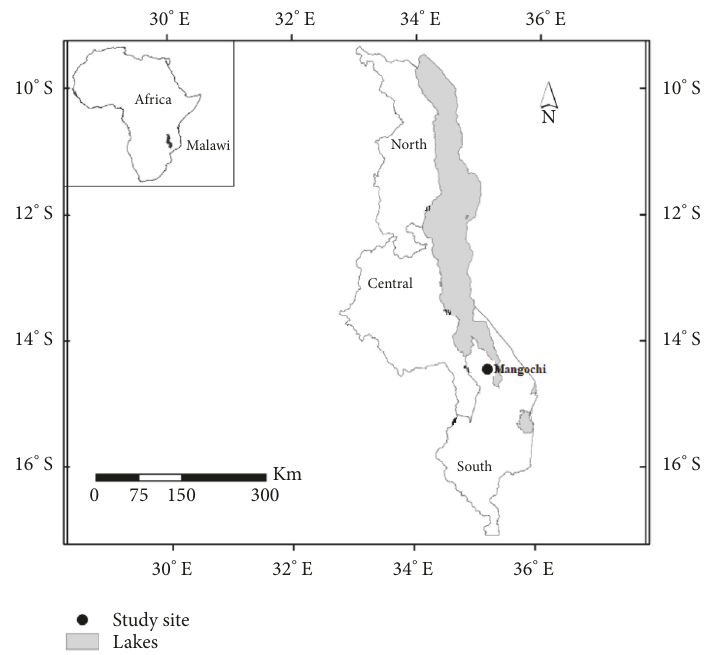
Figure 1: Map of Malawi showing the location of the study